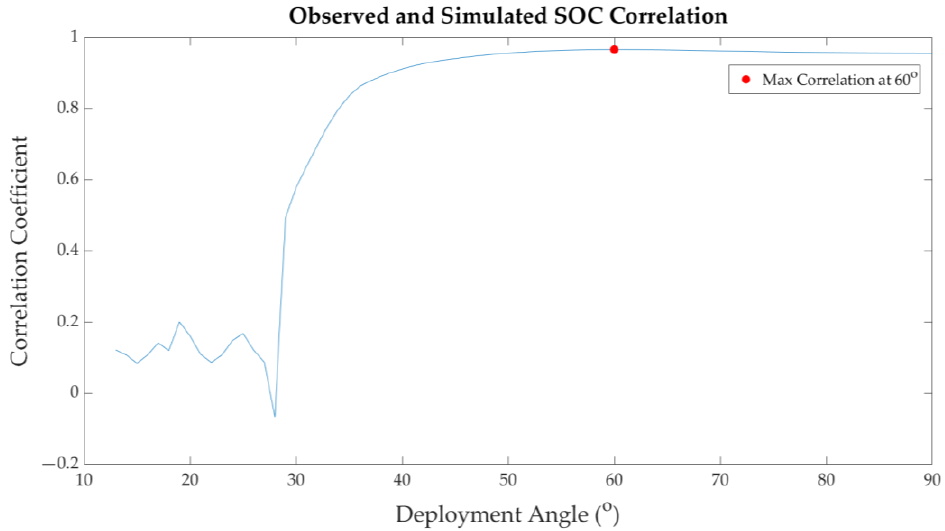
Figure 24. The correlation coefficient between observed and simulated SOC assuming different deployment angles in power simulation.